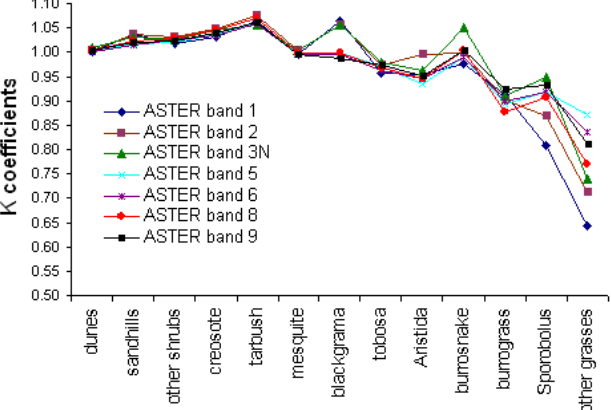
Figure 3. Minnaert regressions for each land cover class and each ASTER reflectance band at the